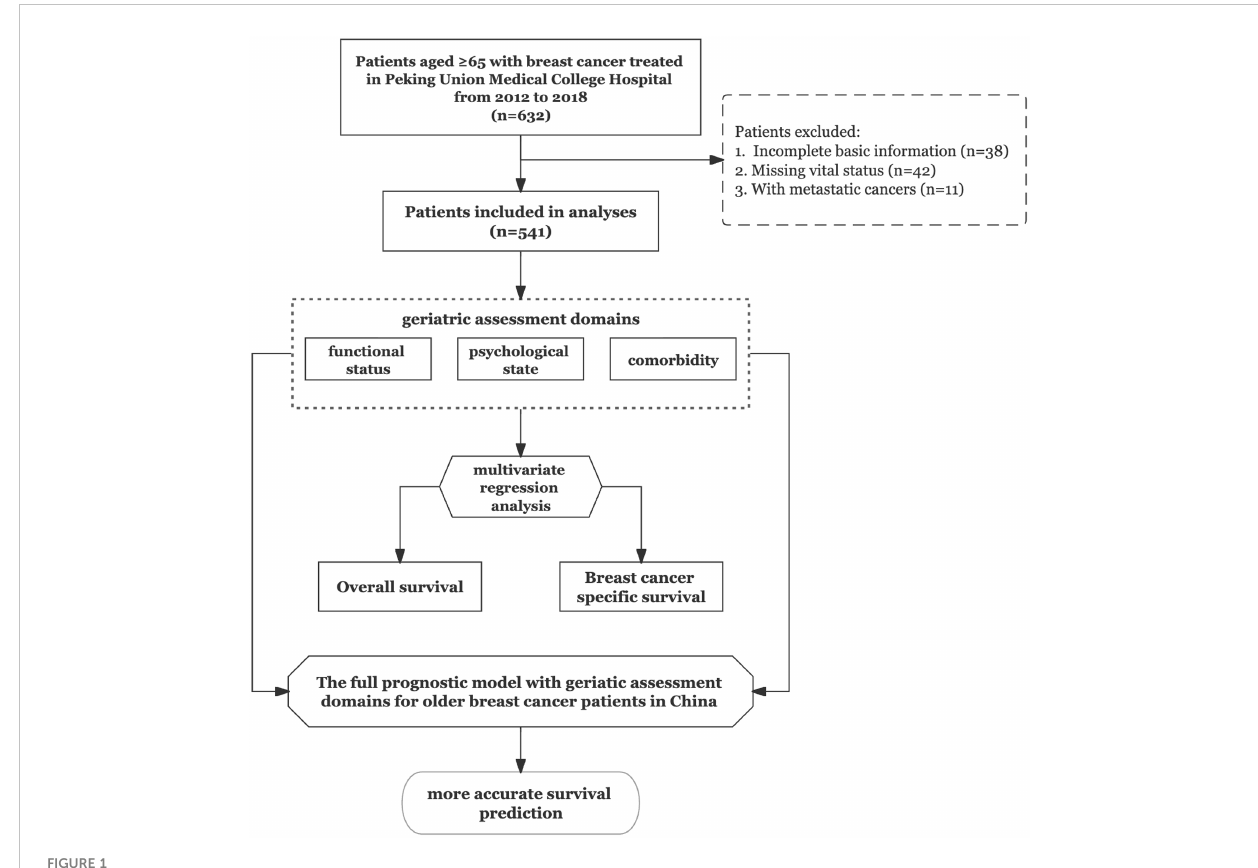
FIGURE 1 Study fl